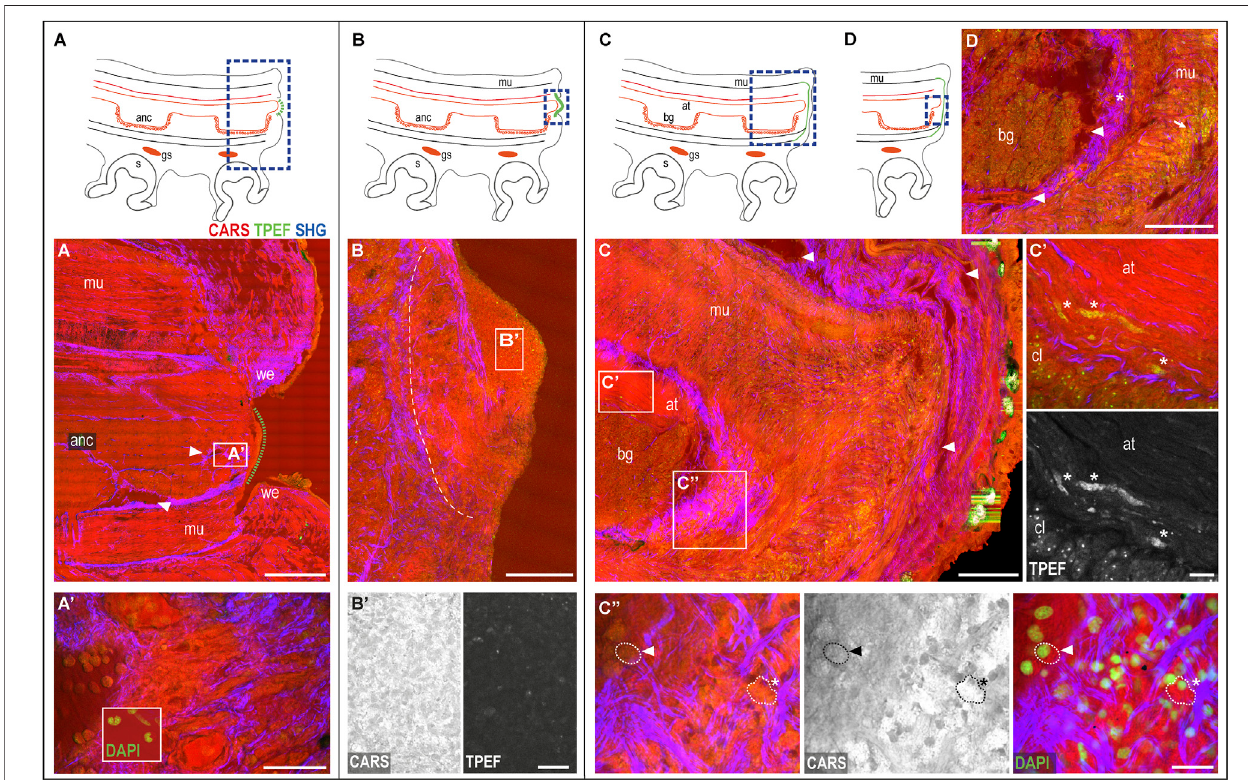
FIGURE 3 | Phases of the arm healing process. Schematic drawings of an arm in the sagittal section (A – D) Describing healing phases imaged with multiphoton microscopy. (A) Wounded dermis forms a rim contracting around the wound. The connective tissue (SHG) narrows around the muscular tissues of the stump contributing to wound closure. A clot of agglutinated blood cells deposits over it (green dotted line) originating from blood vessels in the stump (arrowheads). (A 9 ) Hemocytes released in the stump. DAPI counterstaining shows the peculiar u-shaped nucleus of the hemocytes, which occupies most of the cytoplasm. (B) Clot covers the whole exposed tissue in between the wound epithelium. A boundary line (white dotted line) of the connective tissue (SHG) separates the clot from the underlying and well-differentiated tissues of the stump. (B 9 ) Clot appears as a dense and fi ne network of interdigitated cells, (C) Regenerating epithelium and highly vascularized (arrowheads) covers the clot. Damaged muscles and axonal tracts degenerate (C 9 ) (asterisks). (C 99 ) Hemocytes are released from the blood stream. They change their appearance from circulating round-shaped cells with a small cytoplasm and u-shaped nuclei (dotted line with arrowhead) into amebocyte-like cells with a large and granular cytoplasm, intensely emitted in CARS and TPEF (dotted line with asterisks). DAPI counterstaining shows the nuclei of these cells. (D) Hemocytes are releasedfromthevesselsaroundthenervecord(arrowheads)intotheconnectivetissuearoundit(asterisk),then,invadeallmusclelayersbelowthewoundedepithelium (arrow). Scale bars: 500 µm in (A) , 50 µm in (A 9 ) , 20 µm enlargement in (A 9 ) , 200 µm in (B – D) , and 20 µm in (B 9 ,C 9 ,C 99 ) . Abbreviations: at, axonal tract; bg, brachial ganglion; cl, cellular layer; gs, sucker ganglion; s, sucker; we, wound